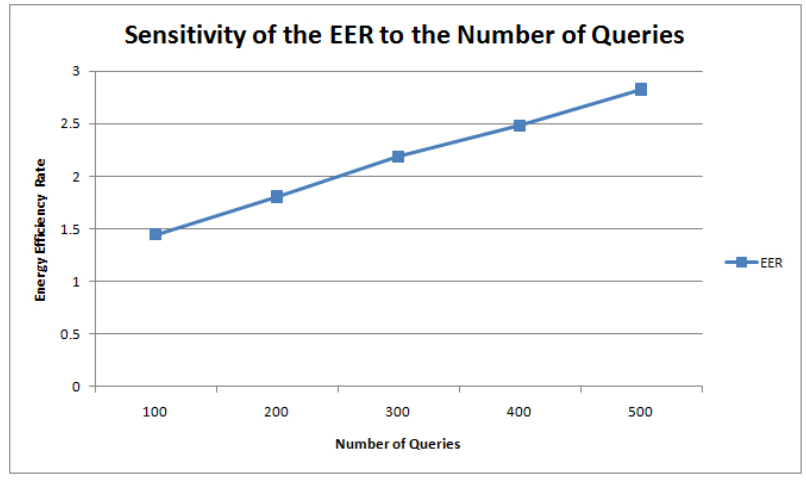
Figure 13. Sensitivity of the EER to the number of queries.